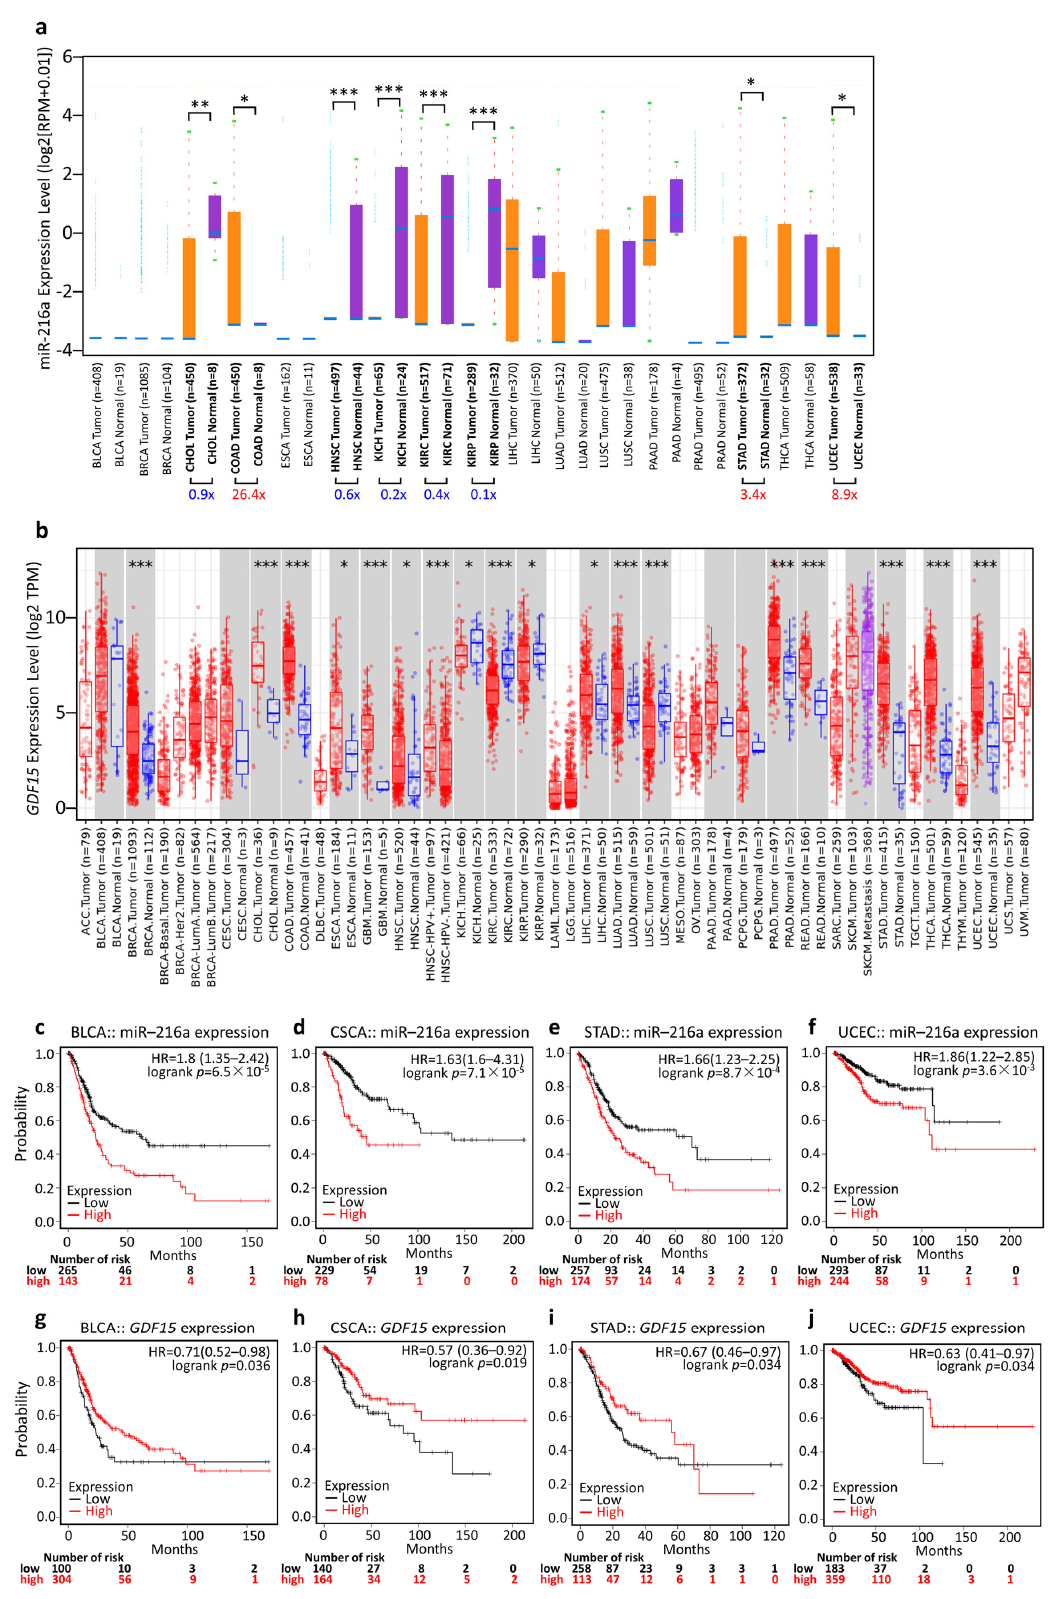
Figure 5. Generalization value of miR-216a/ GDF15 expression in pan-cancer diagnosis and prognosis. Expression profiles of miR-216a ( a ) and GDF15 ( b ) analyzed by ENCORI and Tumor Immunology Estimation Resource version